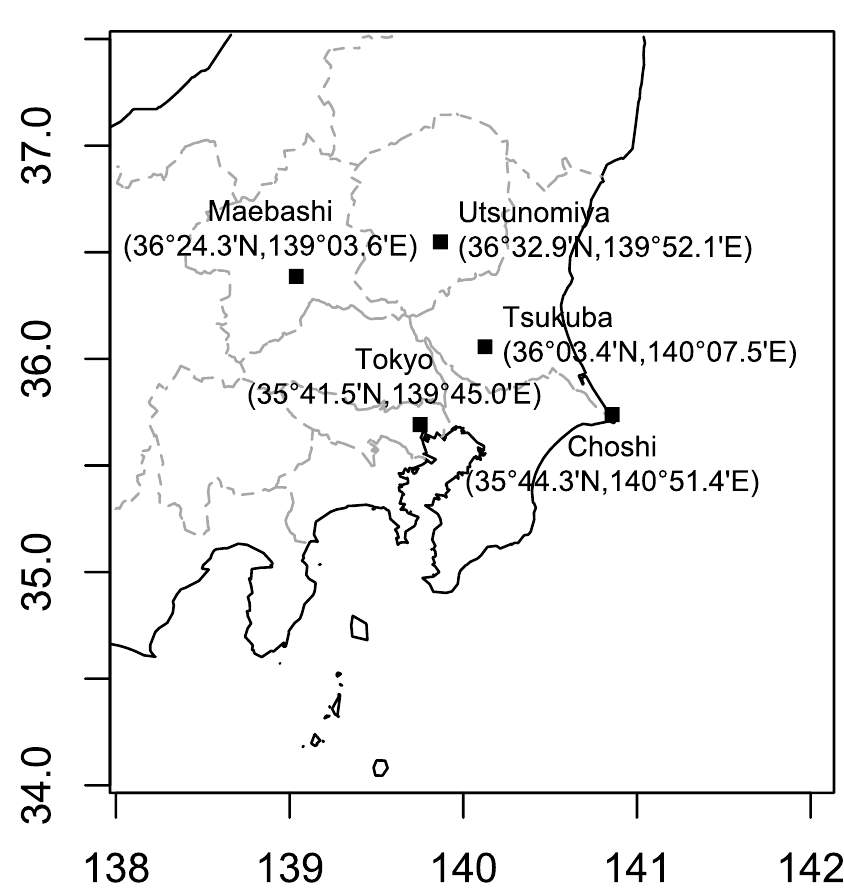
Figure 3. Location of the JMA station which acquires surface GHI observation in the Kanto